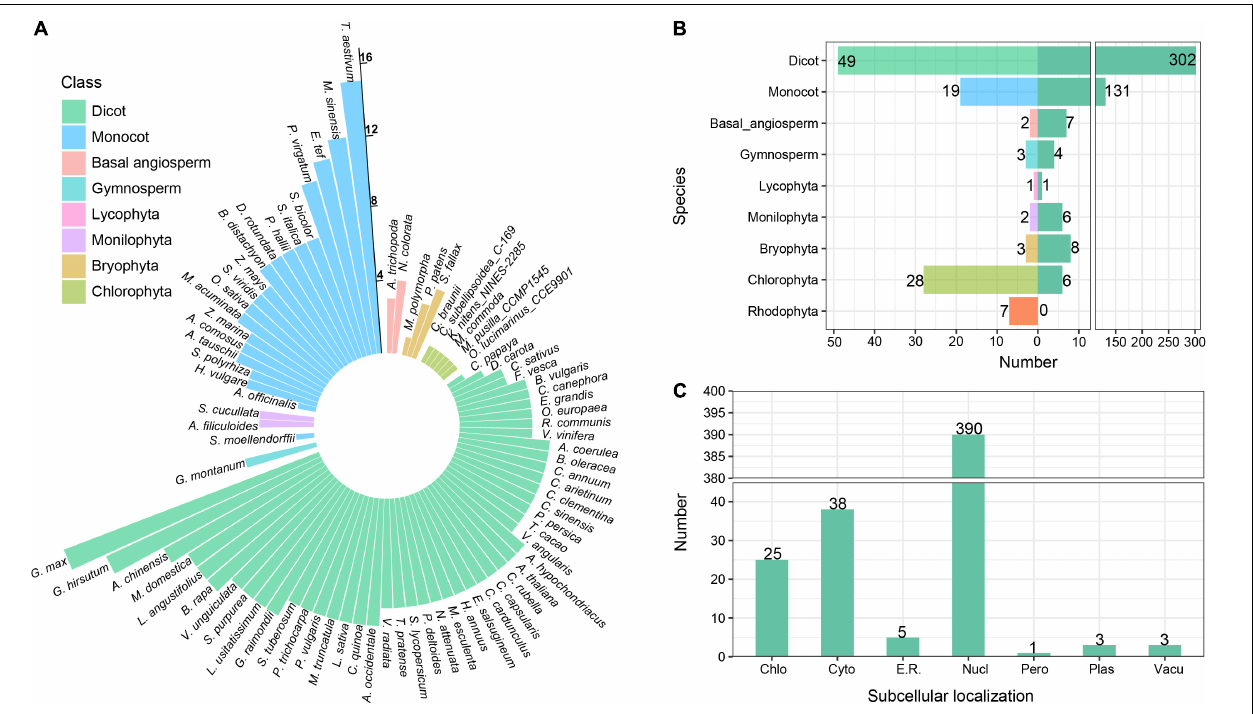
FIGURE 1 | Identification and annotation of CAMTA genes. (A) Number of CAMTA genes in each species. The length of the bar represents the number of CAMTA genes in plant. (B) Number of representative species and identified genes. The left panel represents the number of species, and the right panel represents the number of identified genes. (C) Subcellular localization of identified CAMTA proteins. Chlo, chloroplast; Cyto, cytosol; E.R., Endoplasmic reticulum; Nucl, nucleus; Pero, peroxisome; Plas, plasma membrane; Vacu, vacuolar membrane.